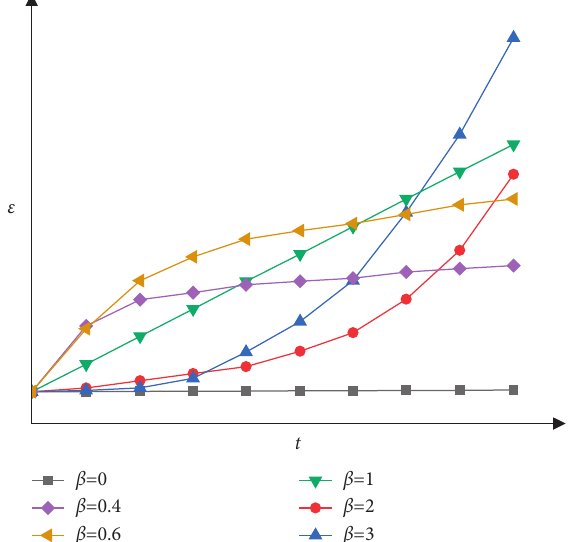
Figure 2: Variation characteristics of the strain with time under different β values.